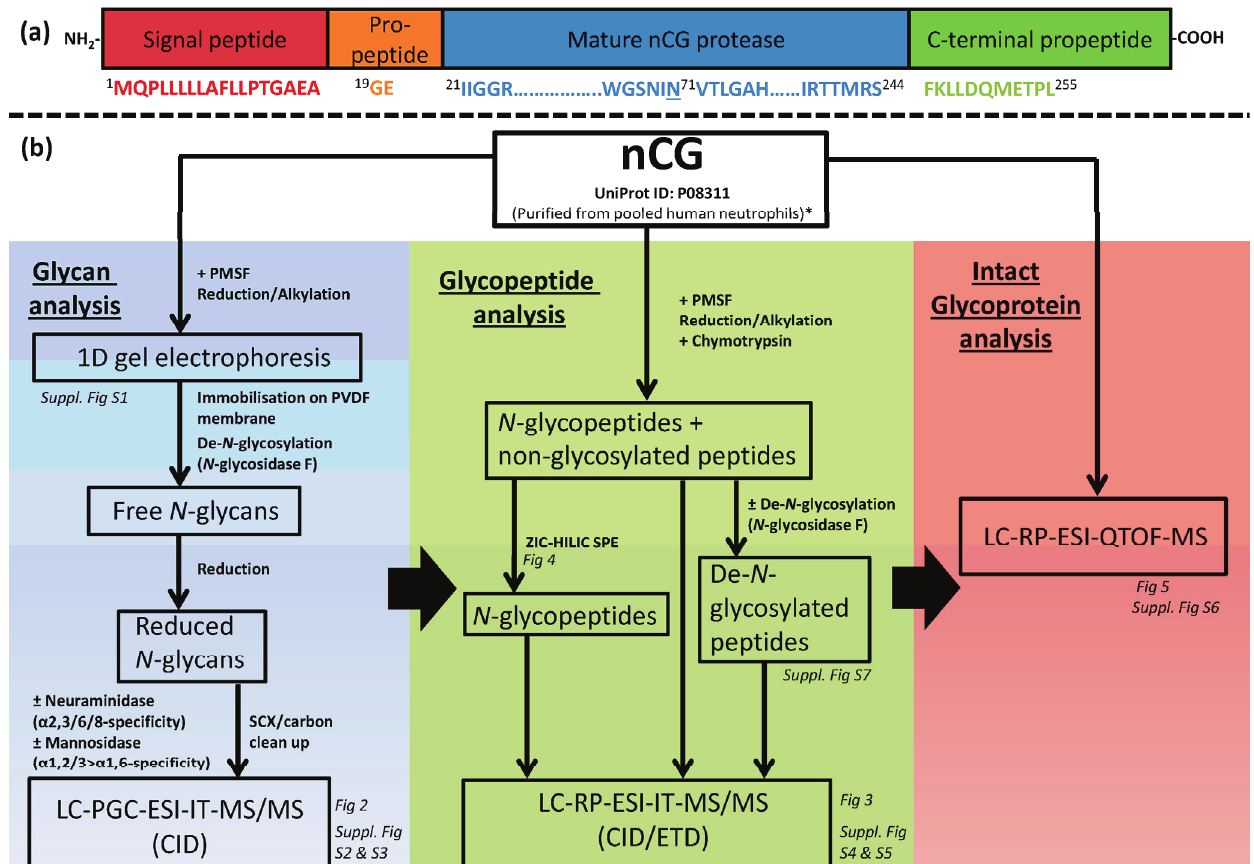
Figure 1. ( a ) Diagram showing the protein sequence of full length nCG consisting of a signal peptide, propeptide, the protease sequence, and a C-terminal propeptide. Numbering is based on the unprocessed nCG polypeptide chain; ( b ) Experimental workflow outlining the characterization of nCG N -glycoprofiling. The LC-MS/MS-centric experiments were divided into the three investigated analyte levels i.e. , N -glycans, N -glycopeptides, and intact glycoprotein. The relevant figures presenting the structural information extracted from the different analyses are indicated. * Other interfering human neutrophil glycoproteins of significant abundance were detected in the investigated protein preparation i.e. , azurocidin and neutrophil elastase